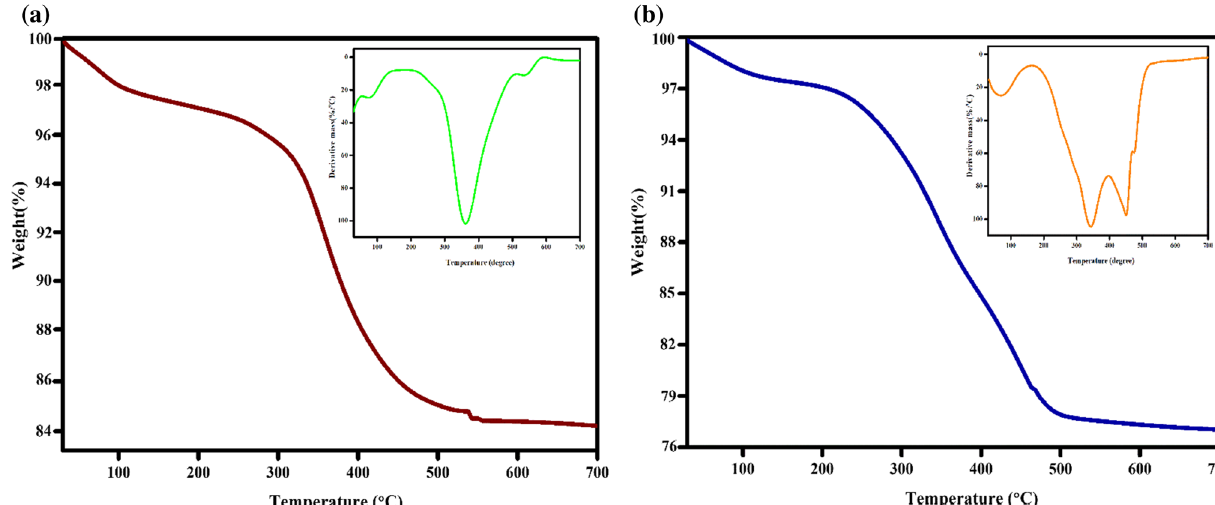
Fig. 7 TGA curves of conventional and mesoporous silicalite-1 and the corresponding DTG curves are given at the inset